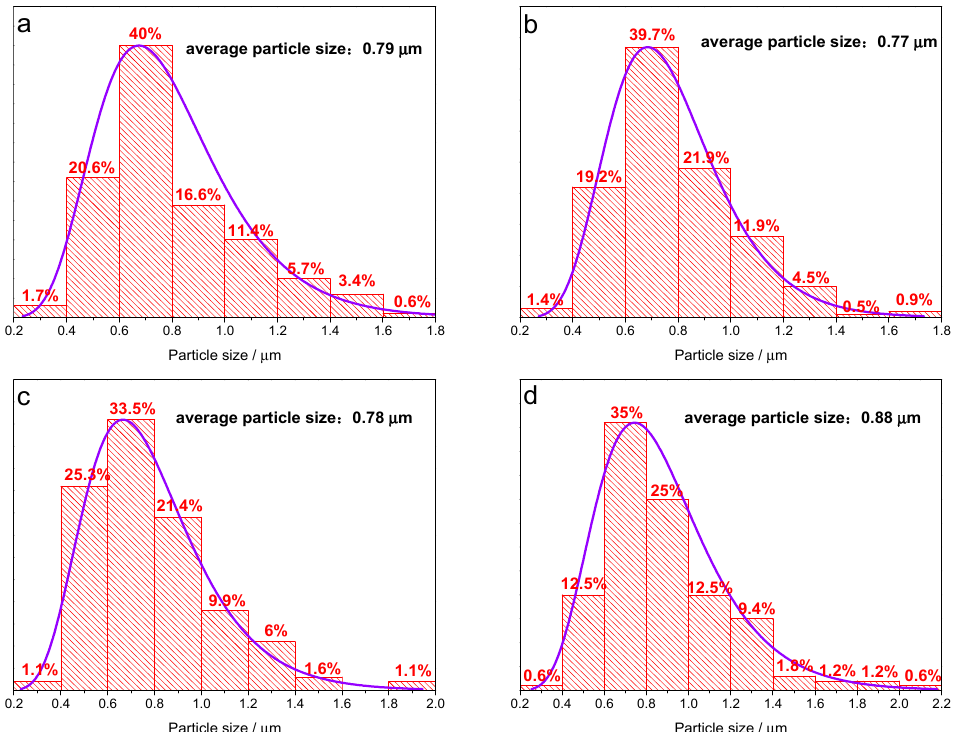
Figure 3. Particle size distribution of as-synthesized LiFePO 4 precursor powder at spray drying temperature of ( a ) 200 °C, ( b ) 250 °C, ( c ) 300 °C and ( d ) 350 °C.